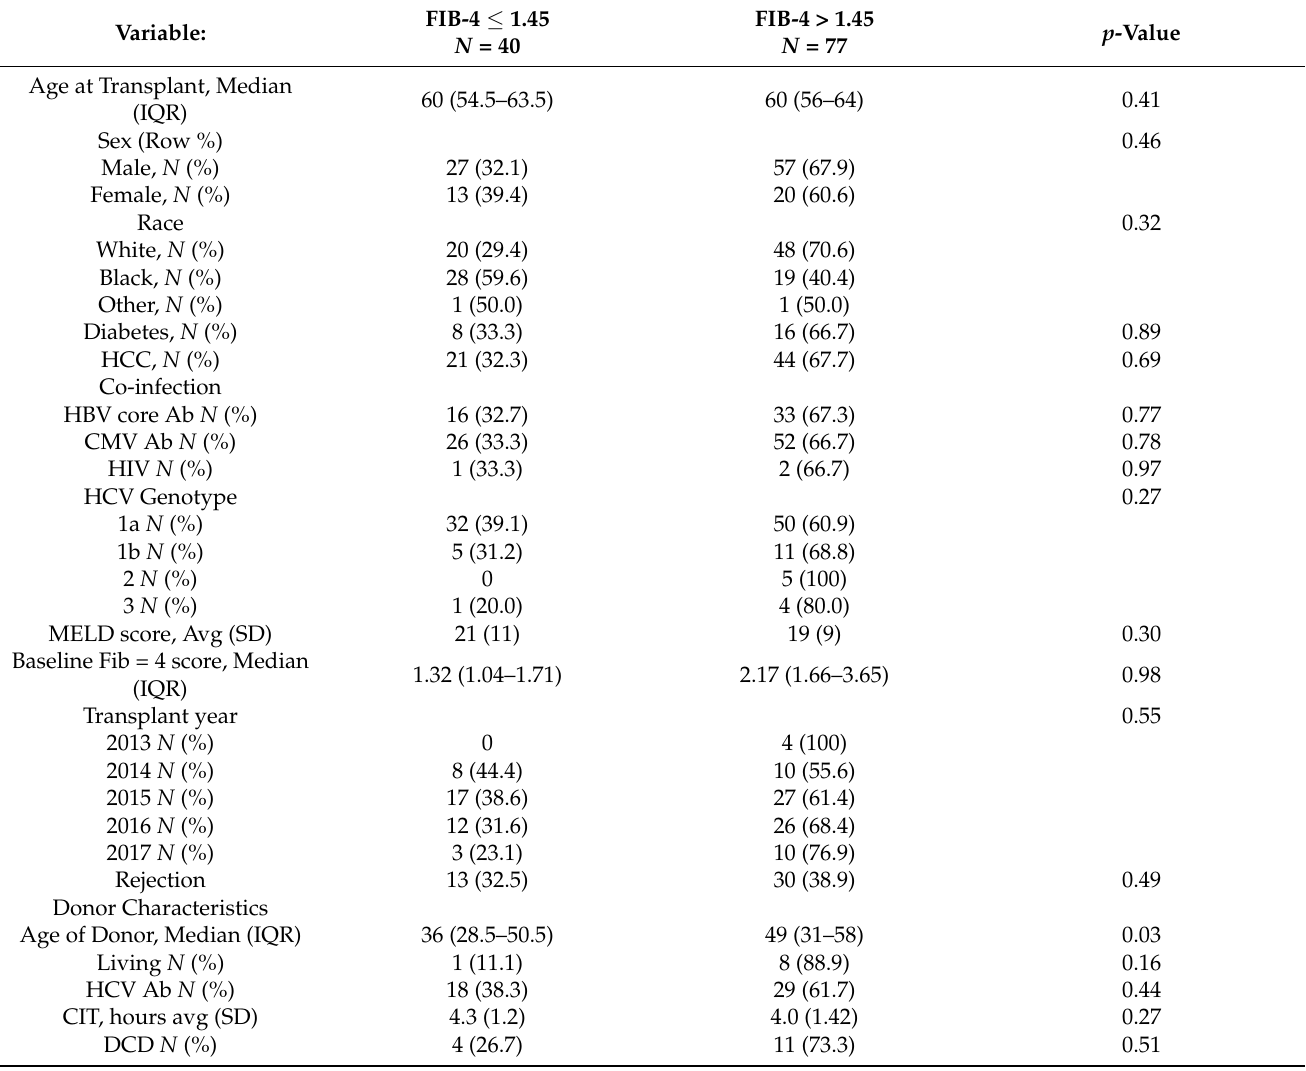
Table 2. Association between liver transplant recipient and donor characteristics and Fib-4 score <1.45 corresponding to little or minimal fibrosis or >1.45 indicating at least moderate fibrosis or